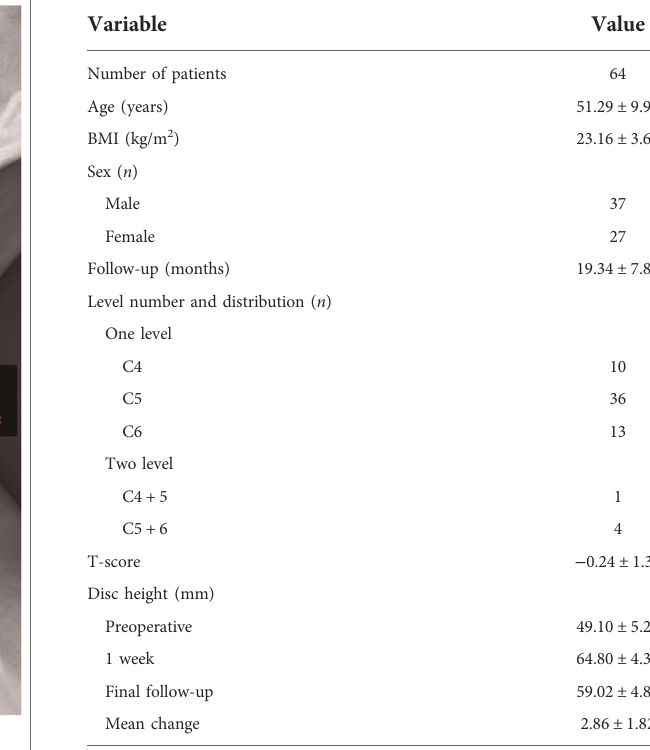
TABLE 1 Preoperative information and disc height of the